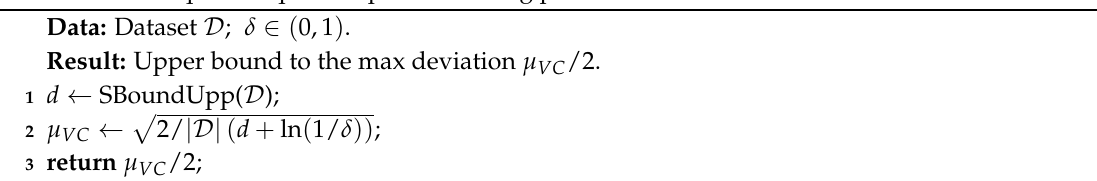
Algorithm 3: ComputeMaxDevVC( D , δ ): computation of an upper bound on the max deviation for the true frequent sequential pattern mining